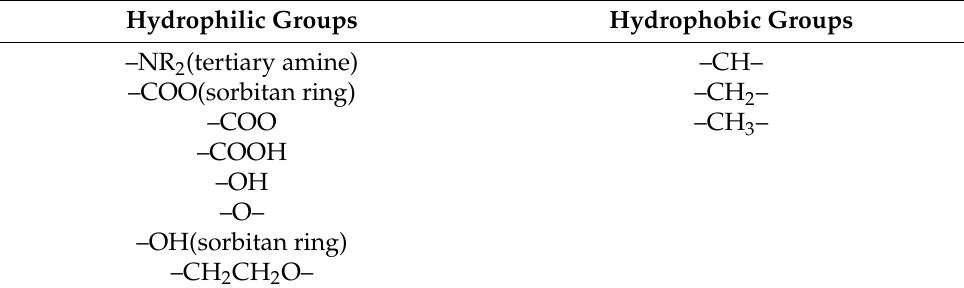
Table 2. Hydrophilic-hydrophobic group.